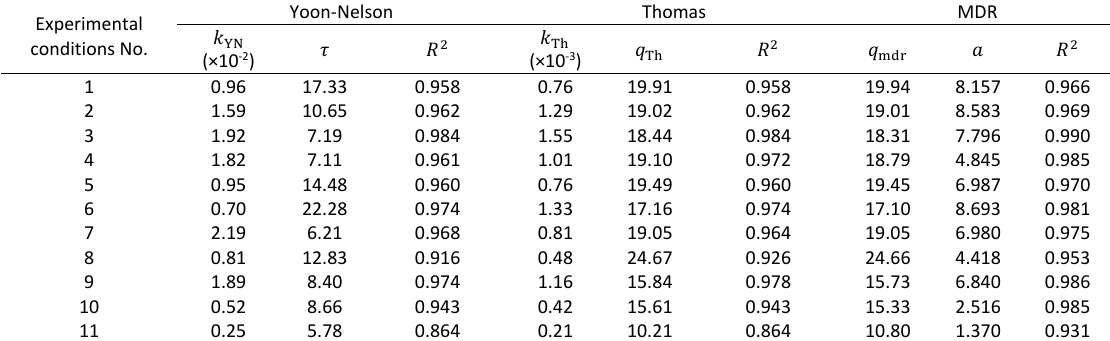
Table 3: Yoon-Nelson, Thomas, and MDR model parameters for phosphate adsorption by am-Zr/MgFe-LDH composite in fixed-bed column at various experimental conditions Yoon-Nelson Thomas Experimental conditions No.